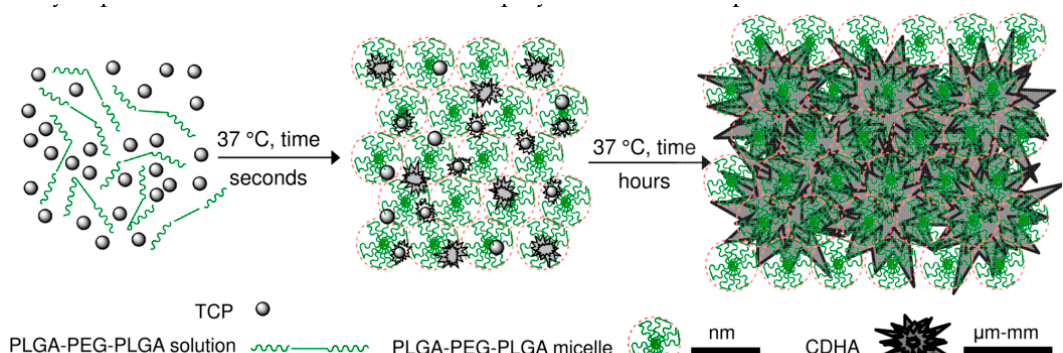
Figure 10. Scheme represents copolymer and α -TCP mixing followed by fast micellization of copolymer at 37 °C accompanied by both α -TCP dissolution and CDHA precipitation. With prolong time in the range of days, the CDHA crystals grow while packing together and increasing their size.